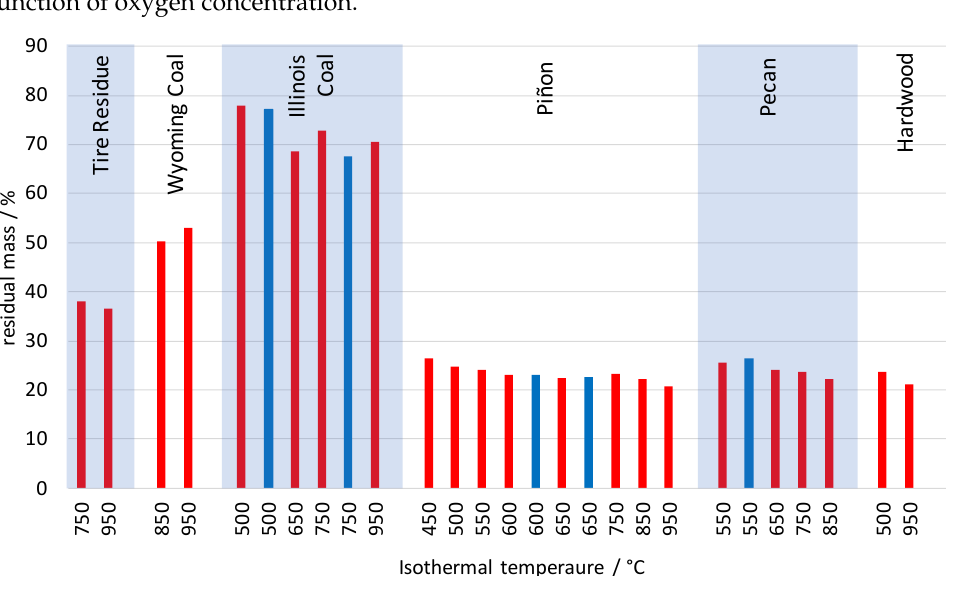
Figure 6. Summary of residual masses of different feedstocks after heating to the indicated isothermal pyrolysis temperature. All samples were prepared in the tube furnace under flowing nitrogen (red bars) or flowing 0.11% (vol.) oxygen in nitrogen (blue bars). From an idealistic standpoint, the smallest residual mass is desired, provided the residue that remains has sufficient porosity. The biomass samples, therefore, appear to be of the greatest interest as they have potential for the highest specific surface areas [32].